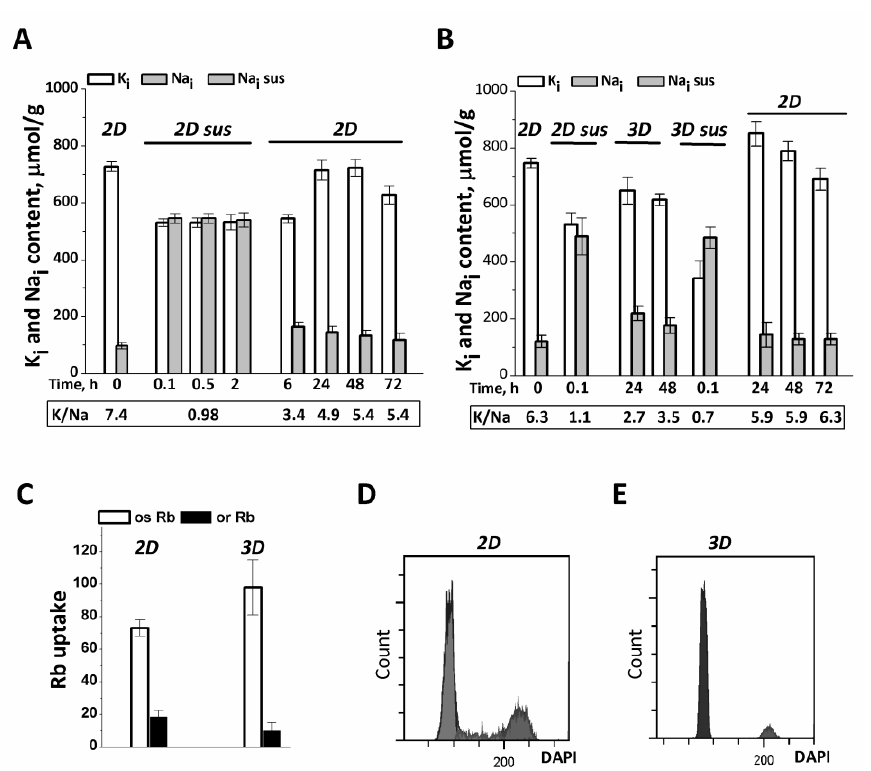
Figure 1. Ion homeostasis of eMSCs during the transition from 2D to 3D culture. ( A ) Na + content increases in eMSCs detached from the monolayer culture ( 2D ) and then maintained in suspension ( 2D sus ). Two-dimensional eMSCs (passage 11) were taken for experiments as a pre-confluent monolayer was achieved; 2D sus —cells from monolayer were harvested by trypsinization, cultivated as suspension in DMEM/F12 medium supplemented with 10% fetal calf serum for 2 h, and then grown as 2D culture ( 2D). ( B ) In spheroids ( 3D ), eMSCs have a low Na + content as compared to cells in suspension ( 2D sus ). Three-dimensional eMSCs (passage 11) were grown in hanging drops at a cell density of 15 × 10 3 cells/30 µL of growth culture medium and then seeded as a monolayer ( 2D). Ion content is presented as µmol/g protein. Data in ( A , B ) were obtained in two separate set of experi- ments. ( C ) Rb influxes, ouabain-inhibitable and ouaban-resistant, in 2D and 3D eMSCs. Rb + influx is presented as µmol/g, 30 min. Data are shown as the mean ± SD, n = 3–5 from one experiment out of three conducted with the same protocol. ( D , E ) Flow cytometric analysis of the distribution of cell cycle phases in 2D ( D ) and 3D € eMSCs.